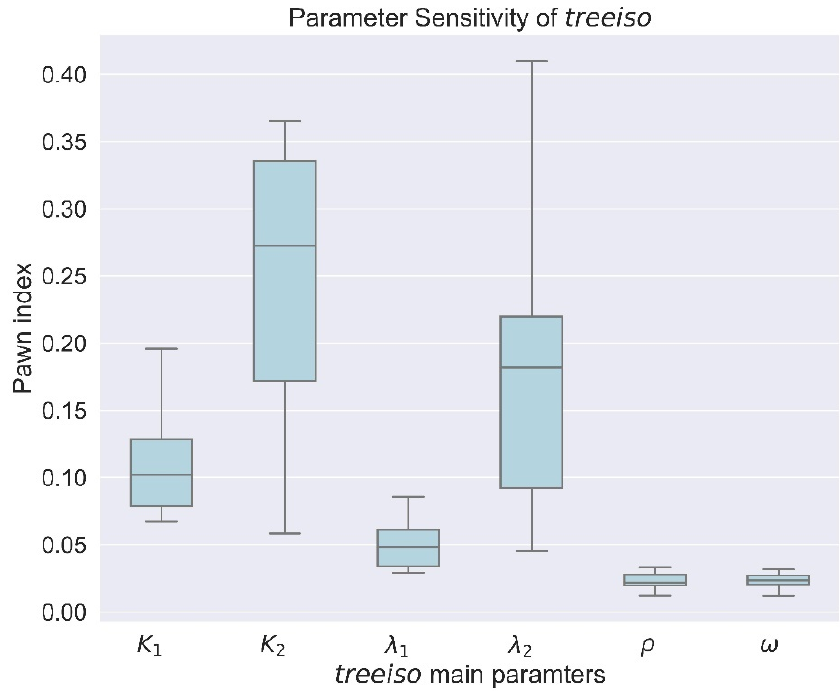
Figure 8. Parameter sensitivity analysis using the PAWN index.